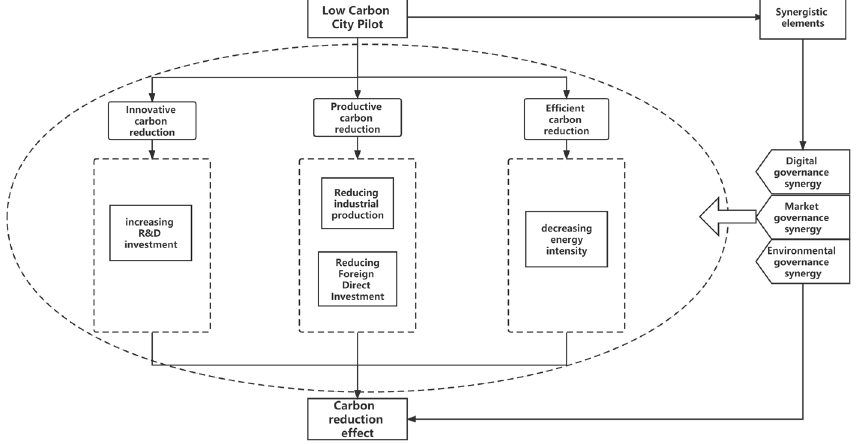
Figure 2. Potential impact mechanisms of LCCP on carbon emission.